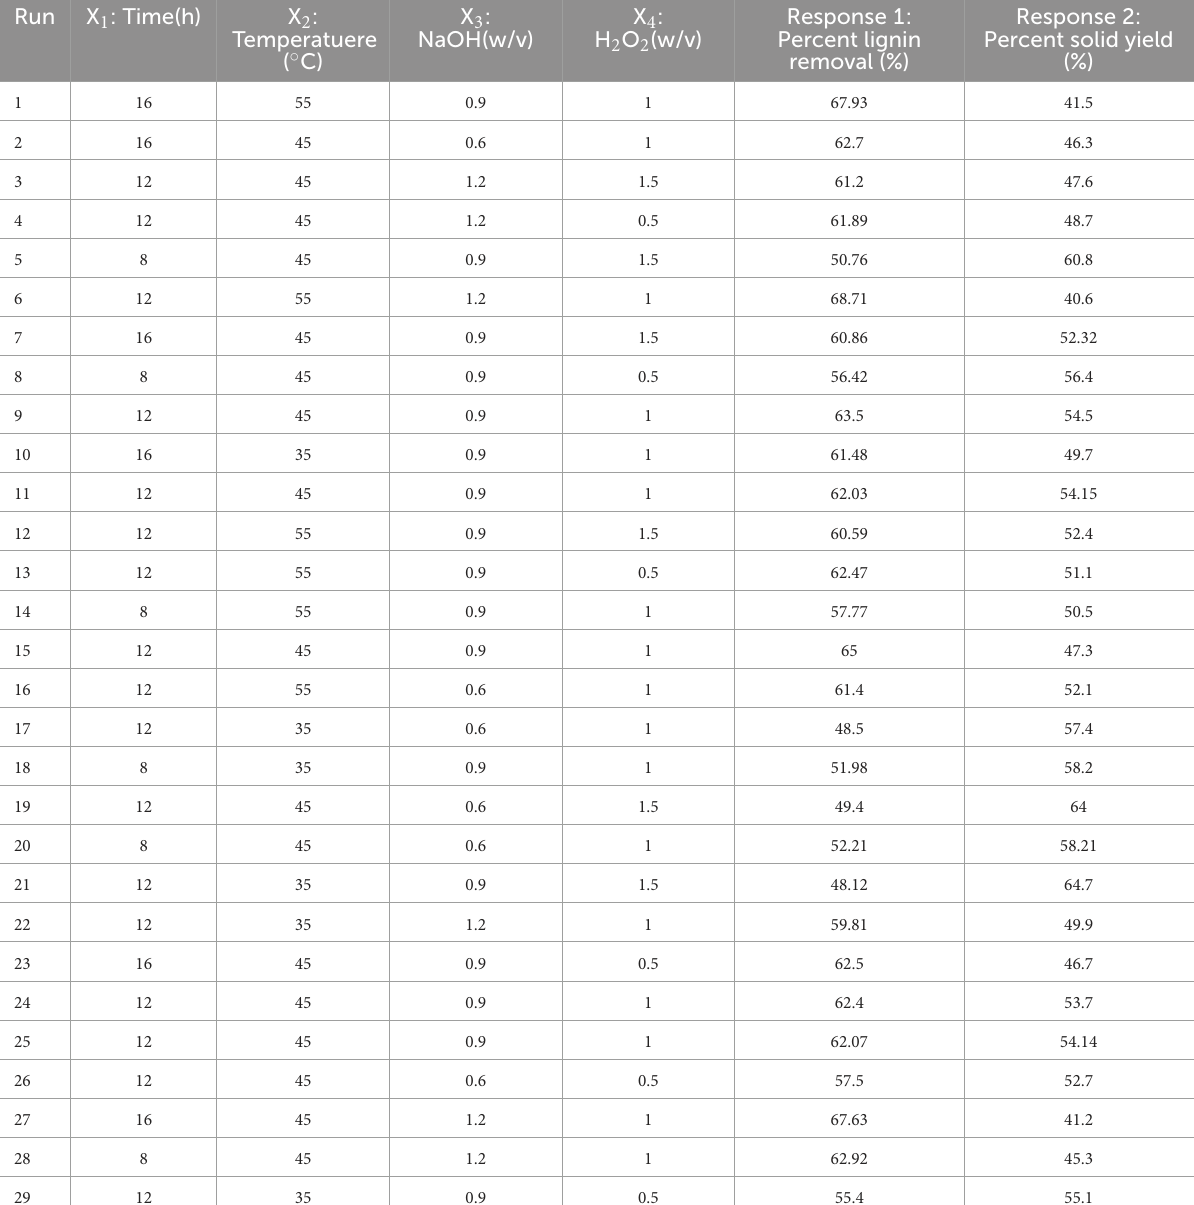
TABLE 1 The design and results of the Box-Behnken